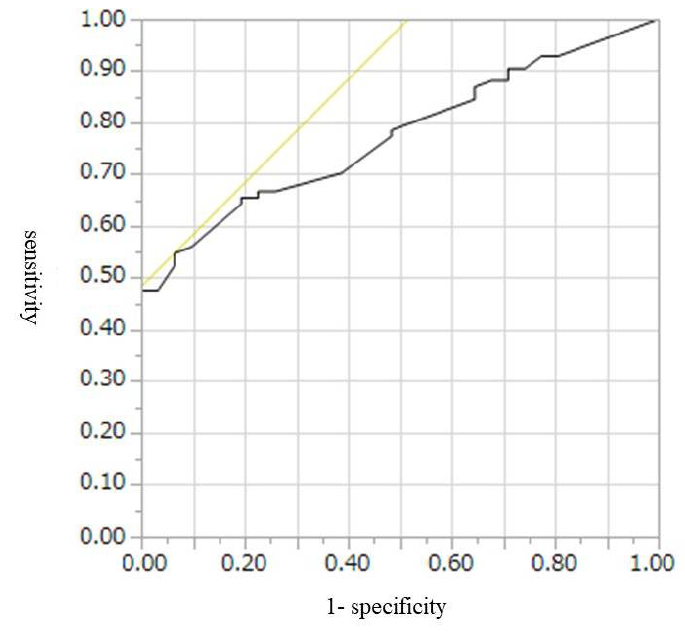
Figure 6. Receiver operating characteristics curve of the presence of mural lesions on conventional EUS for the diagnosis of invasive IPMC. EUS, endoscopic ultrasonography; IPMC, intraductal papillary mucinous neoplasm-associated invasive carcinoma.